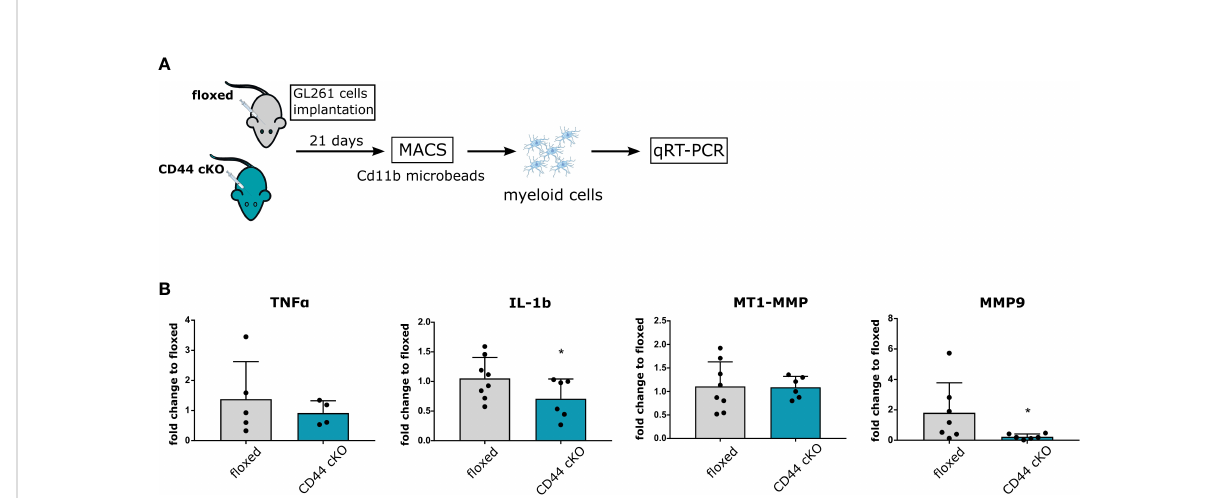
FIGURE 5 CD44 in GAMs mediates increase in MMP9. (A) 2 × 10 4 GL261 cells were implanted in 5-8 weeks old fl oxed or CD44 cKO mice. After 21 days, myeloid cells from tumor-bearing brains were isolated by MACS with Cd11b microbeads. Total RNA was extracted and processed for qRT-PCR analysis. (B) mRNA levels of TNF- a , IL-1b, MMP9 and MT1-MMP. Bar charts represent mRNA levels as fold change to fl oxed mice. Data are presented as mean ± SD. Student ’ s t-Test, *